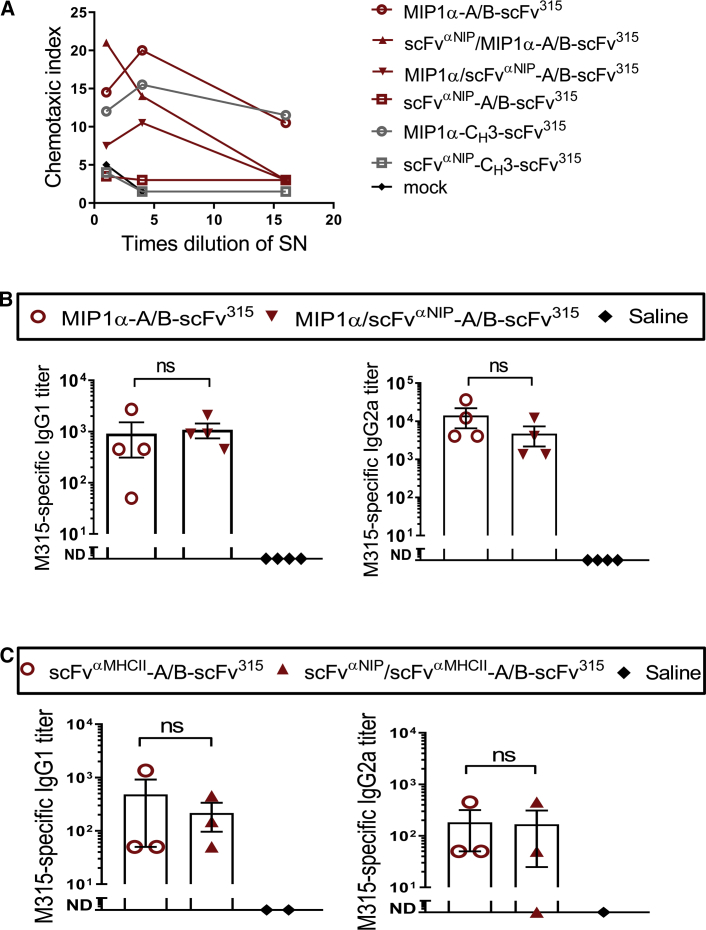
A Single APC-Specific Targeting Unit in the A/B Heterodimeric Vaccine Is Sufficient for Chemotaxis and Induction of Antigen-Specific IgG1 and IgG2a Responses In Vivo(A) Chemotactic activity of the MIP1α targeting unit genetically fused to either the A or B chain of the dimerization motifs, or both, was analyzed in vitro. Dilutions of supernatant from transiently transfected HEK293E cells were tested for their ability to attract CCR1+ CCR5+ ESb-MP cells. (B and C) BALB/c mice were vaccinated with 100 μg (two plasmids) of DNA i.m./EP with A/B heterodimeric vaccines that express either one or two MIP1αs (B), or one or two scFvαMHCIIs (C), as indicated. 36 days (B, n = 4/group) or 14 days (C, n = 3/group, n = 1-2 for saline group) later, antigen (M315)-specific IgG1 and IgG2a were analyzed in sera (mean ± SEM; Mann-Whitney test; ns, not significant; ND, not detectable).